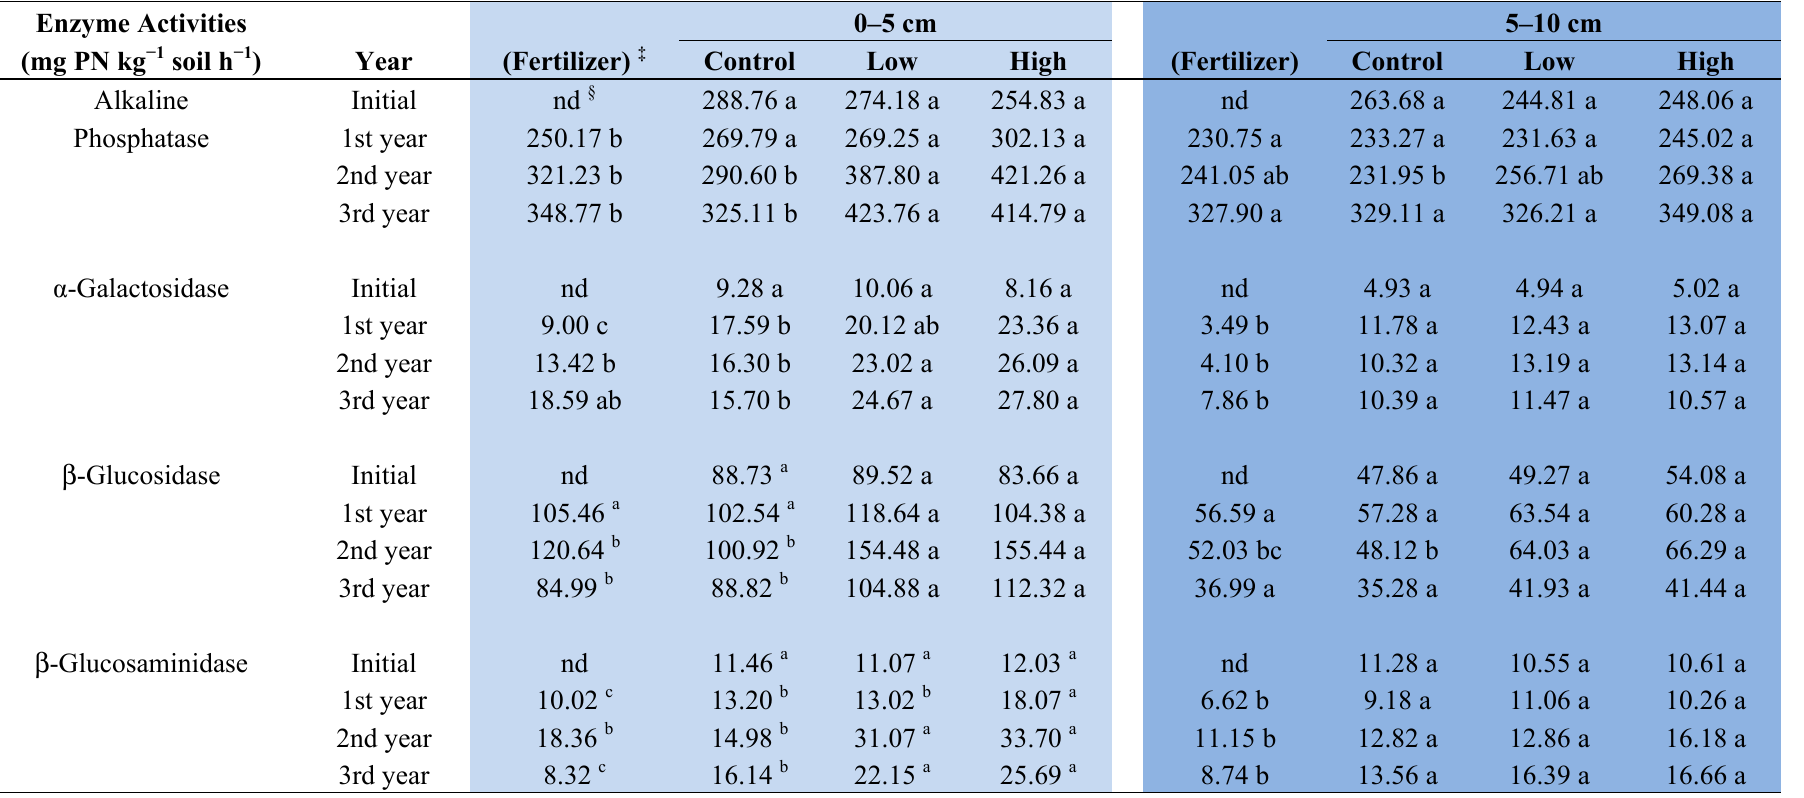
Table 3. Enzyme activities in a silt loam as a function of beef manure application rates in KS †